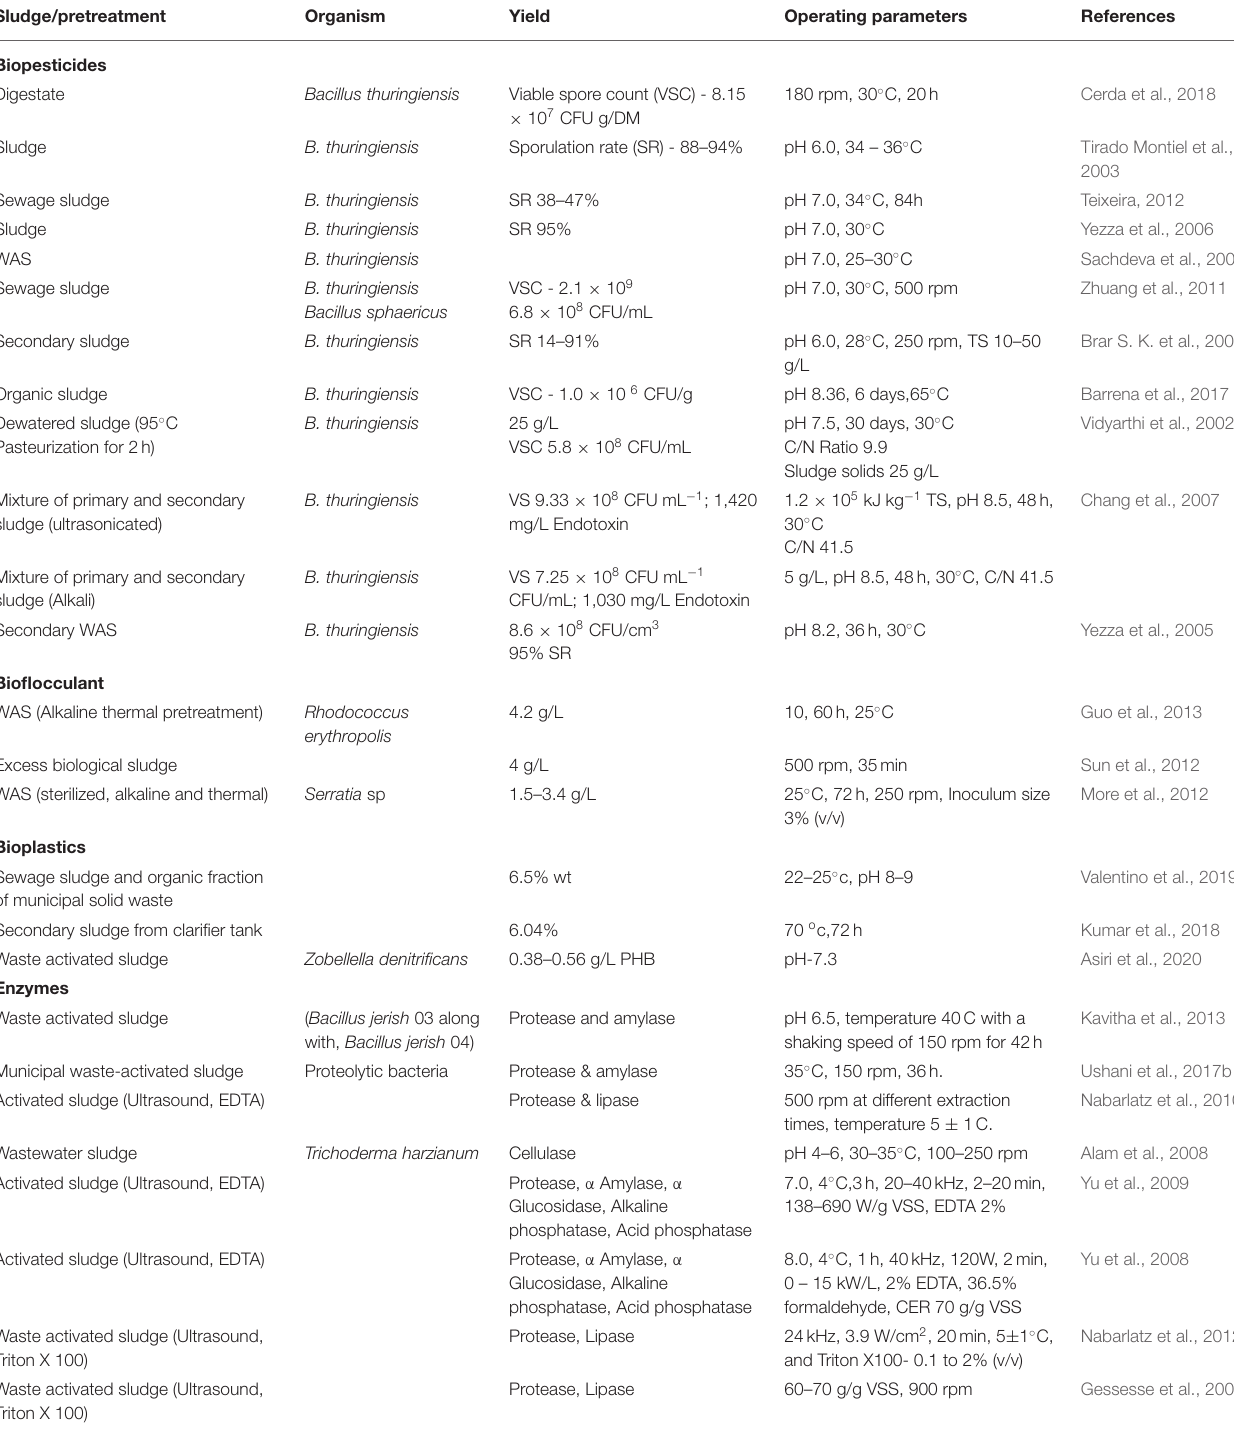
TABLE 4 | Summary of key information on VAP production by biological